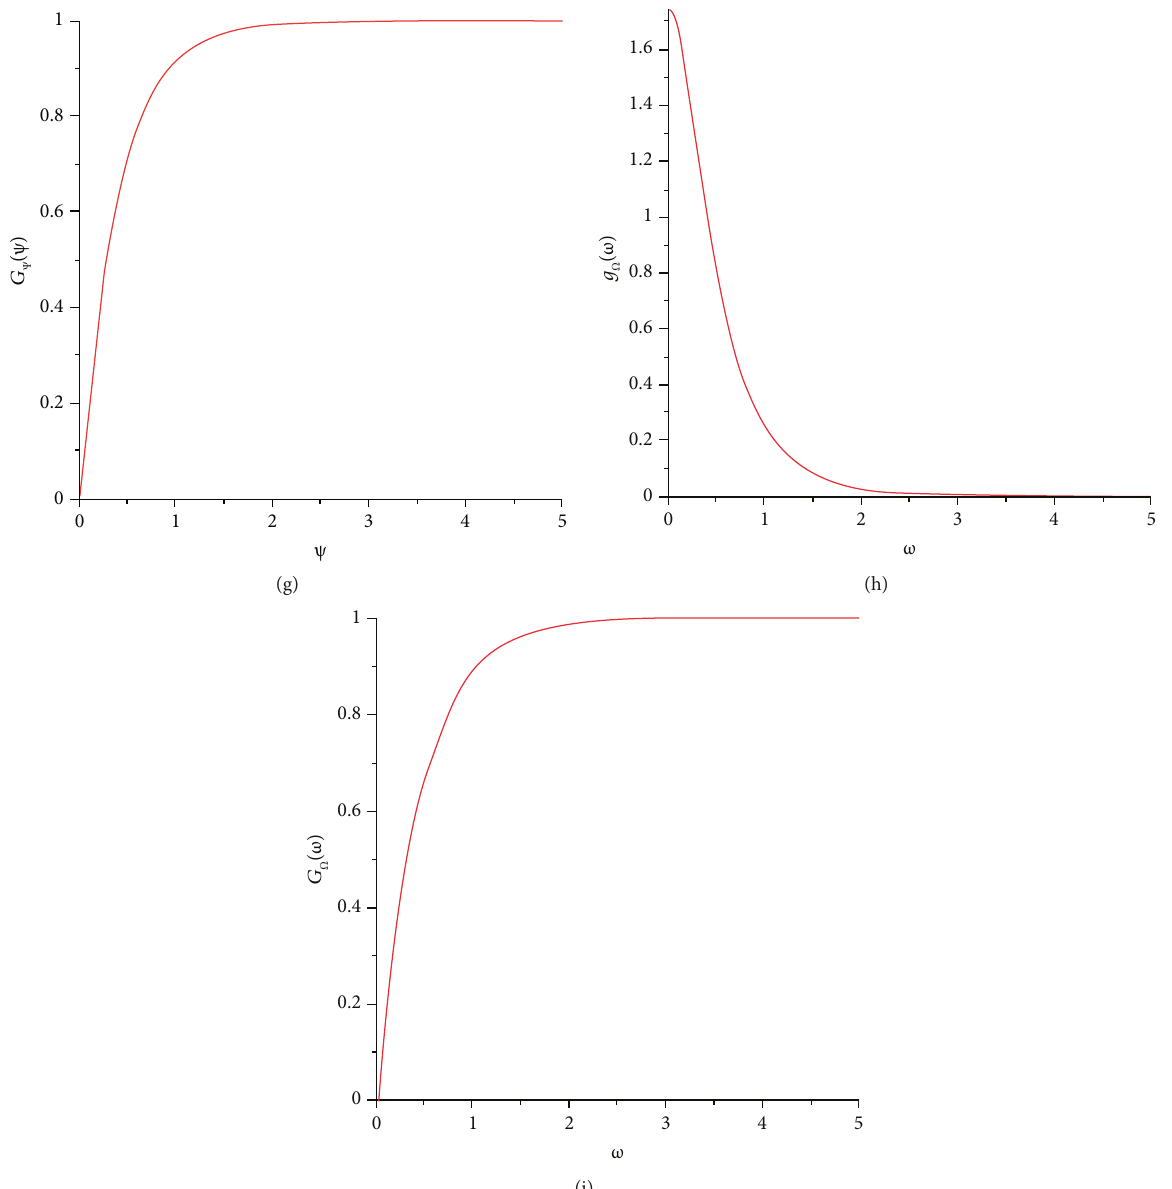
Figure 3: Statistical quantities for the set III of parameters, ( θ , ξ